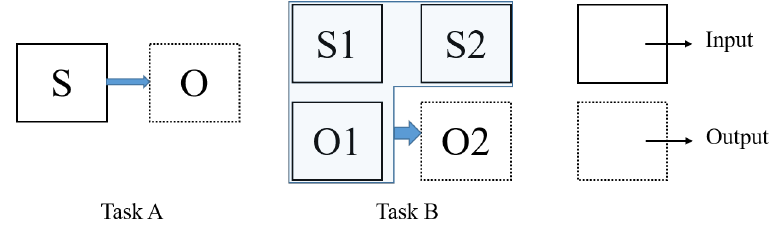
Figure 1. Illustration of two optical simulation